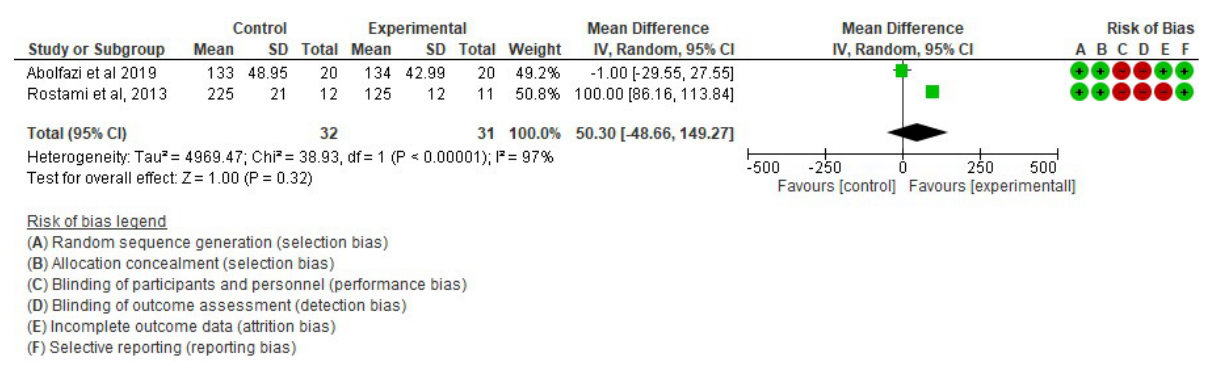
Figure 5. Effect of Mirror Therapy on Range of Motion after 6 weeks post-intervention.